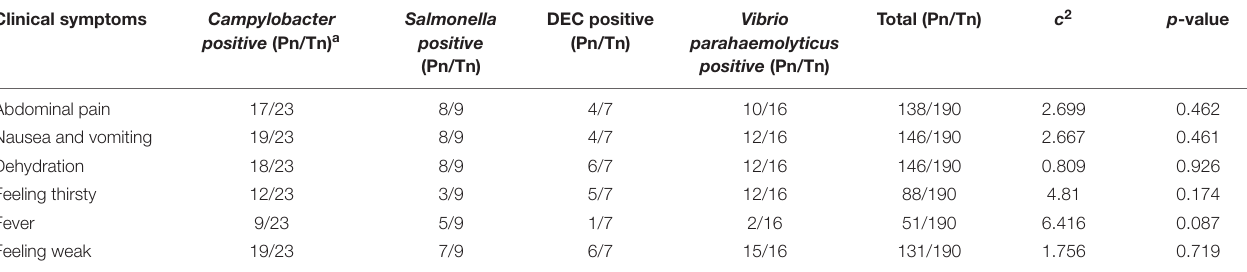
TABLE 1 | Clinical characteristics of the entire tested cases and the characteristics of the culture-positive cases of each pathogen.